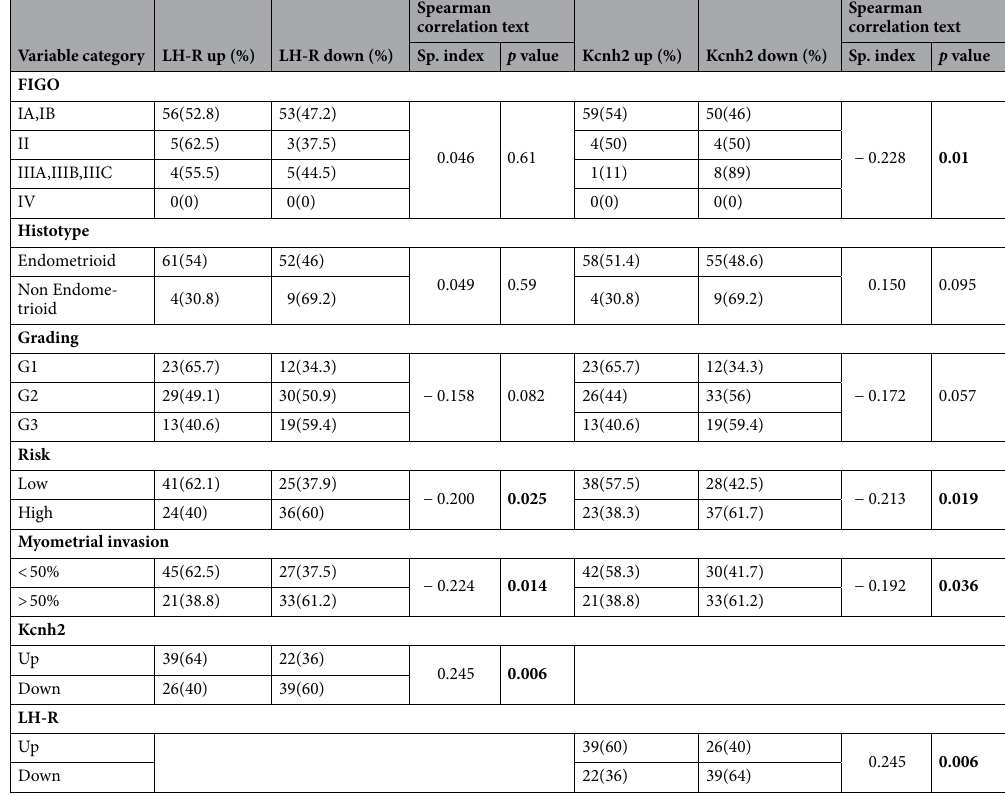
Table 2. Association between LH-R and Kcnh2 mRNA expression and clinicopathological parameters calculated with Spearman method and p values associated to the Spearman index (Sp.index). Significant correlations ( p < 0.05) are highlighted in bold. Kcnh2 and LH-R expression were considered upregulated and downregulated (marked as up and down in the table) for values greater and lower than the median value